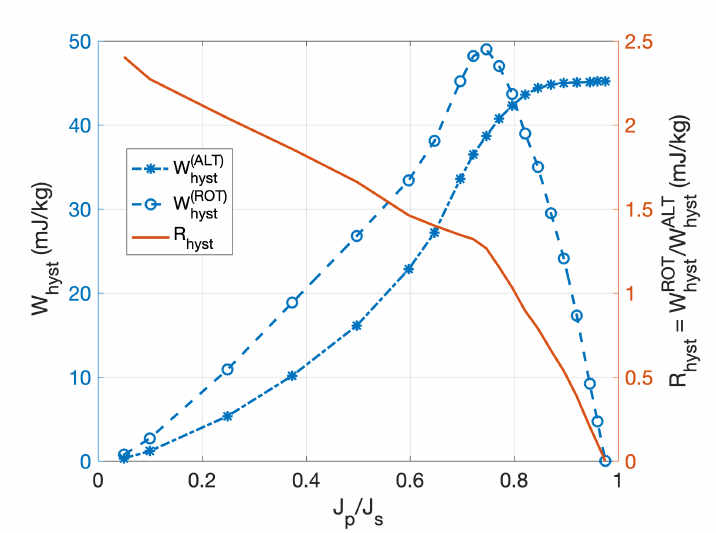
Figure 9. Alternating and rotational hysteresis loss components and their ratio R hyst as a function of the reduced polarization J p / J s for the the non-oriented (NO) 0.356 mm thick Fe-Si sheet (experimental data retrieved from [20]).